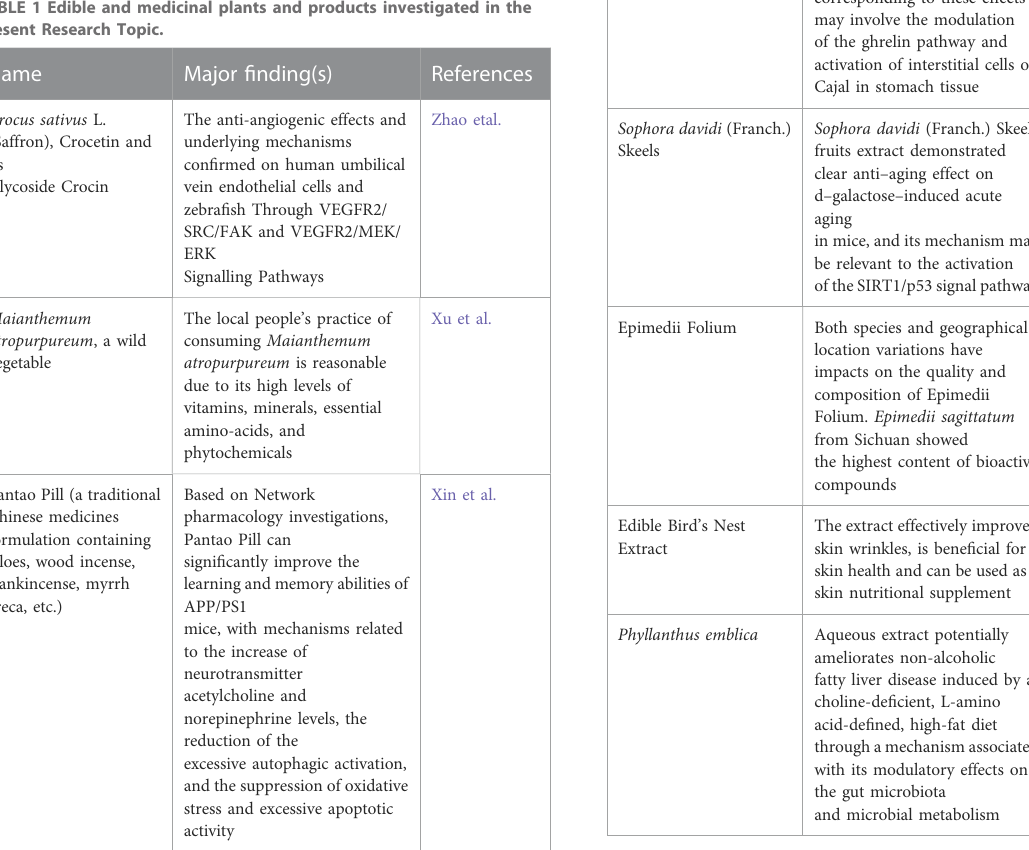
FIGURE 1 Number and citation frequency of medicine food homology related publications. Note: Data were collected from Web of Science Core Research Topic with the following search strategy: Topical Subject = ( “ Medicinal and Edible ” OR “ medicine food homology ” ) OR Title = ( “ Medicinal and Edible ” OR “ medicine food homology ” ) OR Abstract = ( “ Medicinal and Edible ” OR “ medicine food homology ” ), the language was English. A total of 508 papers were obtained, including 53 reviews and 455 articles. Figure only includes studies that met the inclusion criteria of the search strategy (Data as of Jul. 2022).